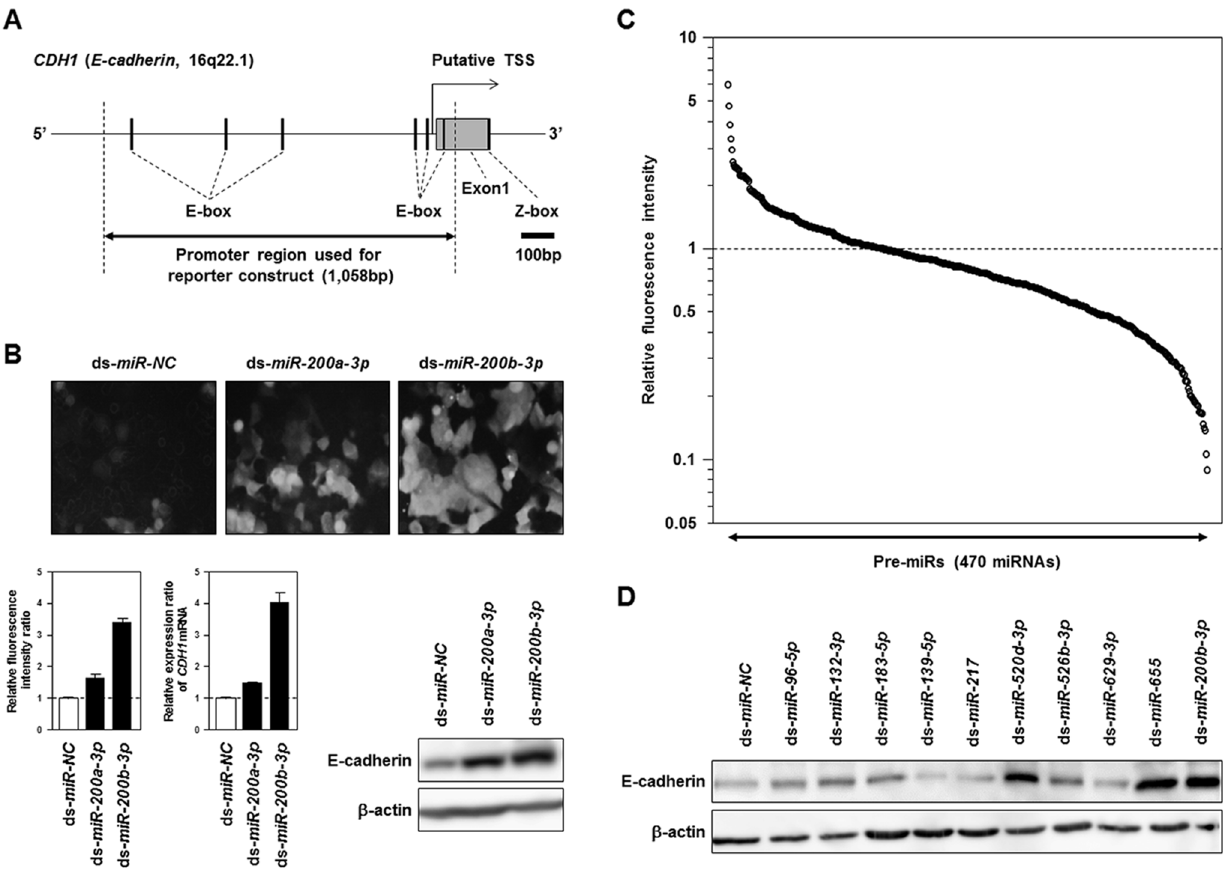
Figure 1. Function-based screening of EMT-suppressive miRNAs using reporter system for investigating CDH1/E-cadherin -promoter activity in Panc1 cells. A , Map of the promoter region of the CDH1/E-cadherin gene. To construct a reporter plasmid, 1,058 bp promoter sequences indicated by the closed arrow in this map was introduced into a promoterless pZsGreen1-1 vector with the ZsGreen1 gene as a reporter gene. A cell- based reporter system was established by isolation of a stable clone with the limiting dilution method after transfection of the construct into Panc1 cells. B , Confirmation of the expression of the ZsGreen1 protein in the cell-based reporter system following transfection of miR-200a or -200b . A stable cell clone with the reporter plasmid was evaluated 96 hours after transient transfection of 10 nM of dsRNA mimicking miR-200a or -200b, or control non-specific miRNA (ds- miR-200a , ds- miR-200b or ds- NC ) (Ambion). Upper , Detection of ZsGreen1 in these transfectants using fluorescence micrographs. Lower , Quantification of fluorescence intensity in these transfectants ( Left ). Results of the TaqMan real-time RT-PCR analysis ( Middle ) and Western blot analysis ( Right ) for expression of the CDH1/E-cadherin transcript and protein, respectively, in these transfectants. C , Results of the function-based screening of EMT-suppressive miRNAs in a cell-based reporter system using Pre-miR TM miRNA Precursor Library-Human V3 (Ambion) containing 470 dsRNAs mimicking human mature miRNAs. The fluorescence intensity of ZsGreen1 was evaluated by fluorescence microplate reader in duplicate. The relative fluorescence intensity in each transfectant was calculated by normalization of each result to the fluorescence intensity in control cells transfected with non-specific miRNA (see Table 1 and Table S2). The lower closed arrow indicates the 470 miRNAs examined. D , Western blot analysis of E-cadherin protein levels in parental Panc1 cells 96 hours after transient transfection with 10 nM of ds- NC or 10 nM of ds-miRNAs mimicking miR-96-5p, -132-3p, -183-5p, -139-5p, -217, -520d-3p, -526b-3p, -629-3p, -655 and -200b-3p . Because miR-200b has already been confirmed to induce expression of the CDH1/E-cadherin transcript and protein in this study (Fig. 1B) and multiple previous studies, ds- miR-200b was used as a positive control in this analysis.